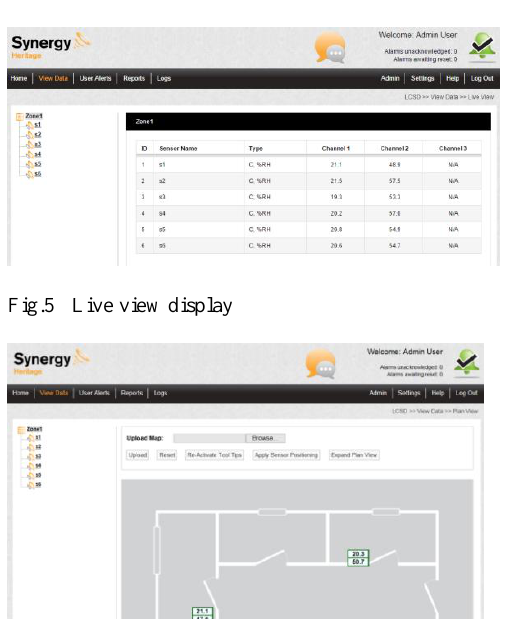
Fig. 1 Layout plan of sensors (indicating by red dots) in Room 902 of an offsite store